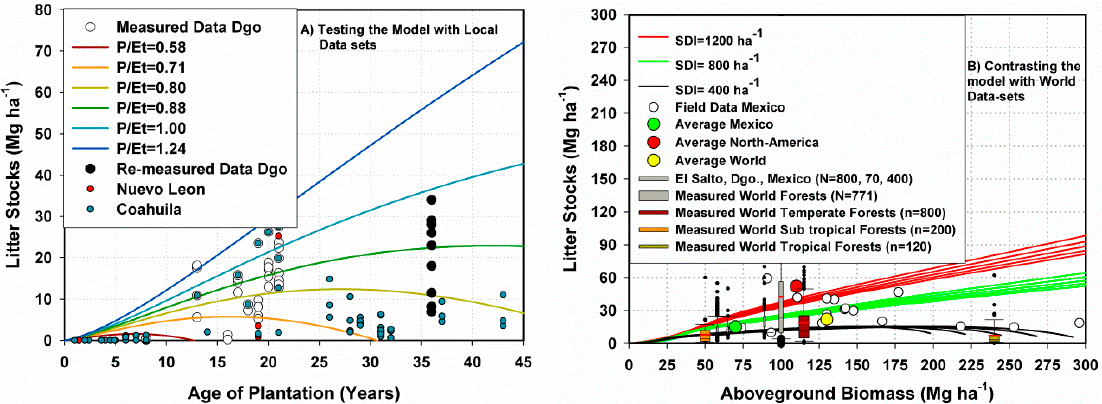
Figure 5. The mass balance budget model, MBM LS , for evaluating litter stocks and accumulation rates for ( A ) non-industrial planted forests of northern Mexico overlapped with ( B ) some other regional, national and World litter stock data source. SDI = stand density index with five different site index curves for each SDI.